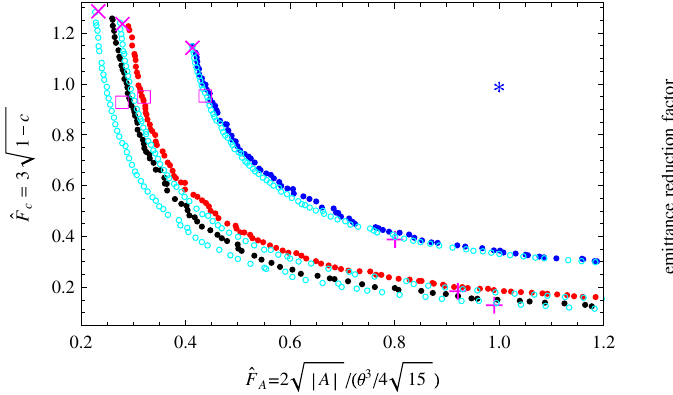
FIG. 1. Pareto-optimal solutions in the objective space. The colored dots are multiobjective optimizations of 33-slice dipoles whose maximum field is higher than the reference dipole by a factor of 2 (blue), 4 (red), and 6 (black). The markers (pink) represent results of single-objective PGA optimization of AME ( (cid:2) , 65 slices), TME ( þ , 65 slices), and EME ( h , 33 slices). The blue star marks the uniform dipole. The cyan circles are opti- mizations based on simplified field profiles (linear-ramp model discussed later). Longer tails continuing off the lower-right corner are not shown.